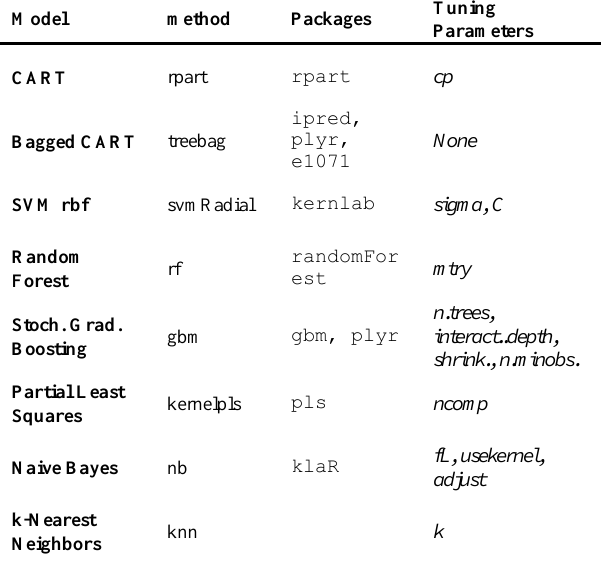
Table 1. Models available via the caret